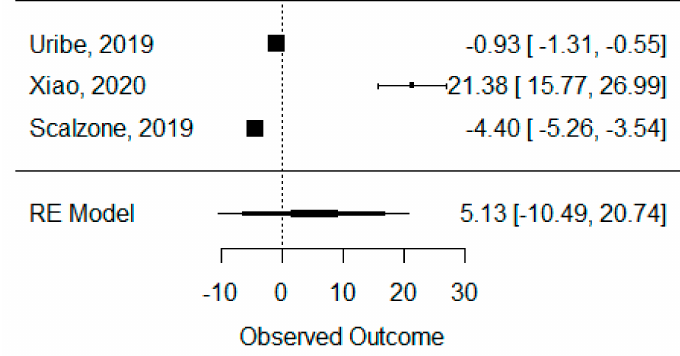
Figure 4. Forest plot for the standardized mean difference obtained for bone height synthetic measures reported in the included systematic